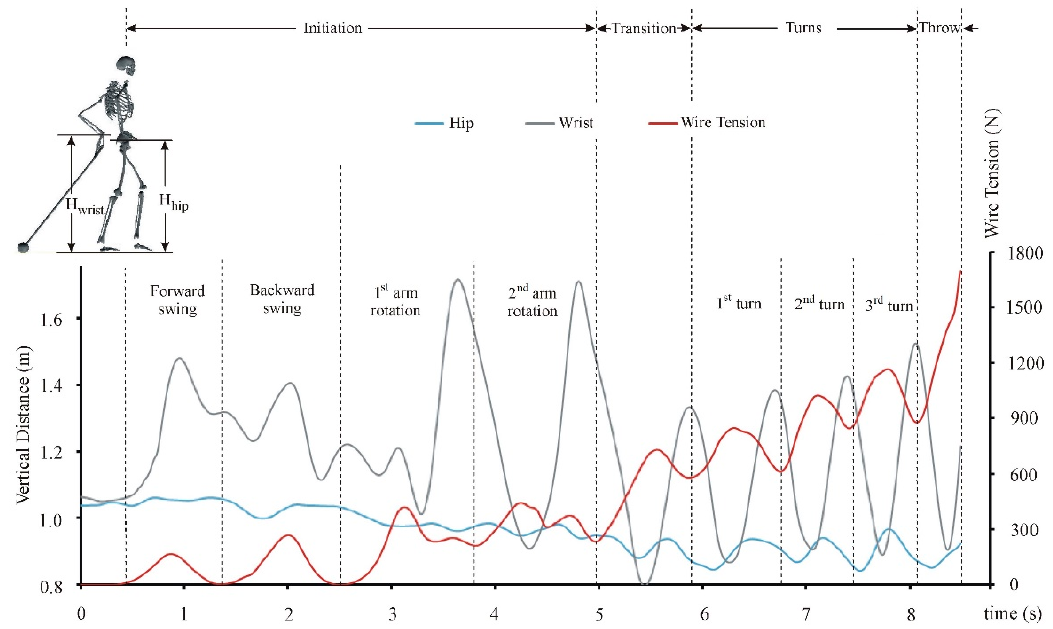
Figure 7. The upper and lower limb coordination (i.e., motor control pattern) revealed by the vertical distances of hip and wrist as well as the wire tension during a hammer throw by a college-level athlete.